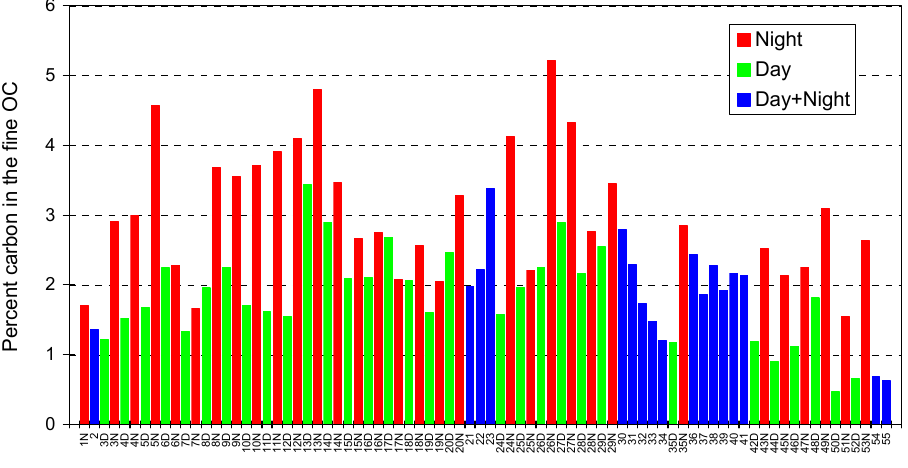
Fig. 2. Time series for fine PM (PM